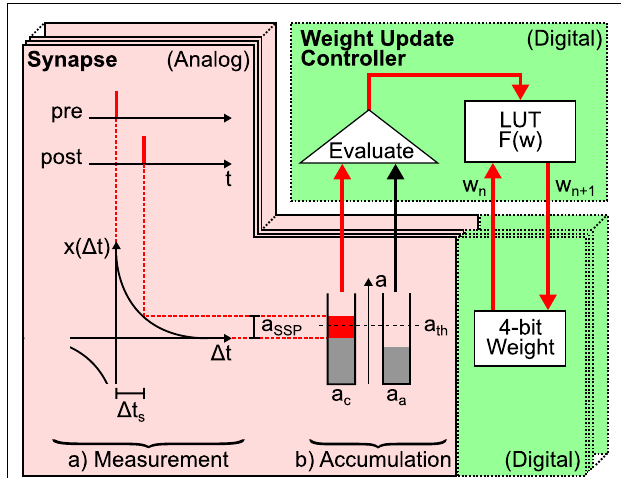
FIGURE 2 | Schematic drawing of local hardware synapses which are consecutively processed by a global weight update controller. Analog circuits are highlighted in red (with solid frame) and digital circuits in green (dashed frames).The spike-timing-dependence (here one standard spike pair (SSP) with ∆ t s , see text) between the pre- and postsynaptic neuron is (a) measured (here a SSP ) and (b) accumulated (here to a c in case of a causal spike pair, a a for anti-causal spike pairs is not affected).Then, the global weight update controller evaluates the accumulated spike-timing-dependence by means of a crossed threshold a th (here a c > a th ) and modifies the digital weight of the hardware synapse accordingly.The new synaptic weight w n + 1 is retrieved from the LUT according to the accumulated spike-timing-dependence and the current weight w n and is written back to the hardware synapse.The analog measurement and accumulation circuit is furthermore minimized by using the reduced symmetric nearest-neighbor spike pairing scheme (Morrison et al., 2008): instead of considering all past and future spikes (all-to-all spike pairing scheme), only the latest and the following spike at both terminals of the synapse are taken into